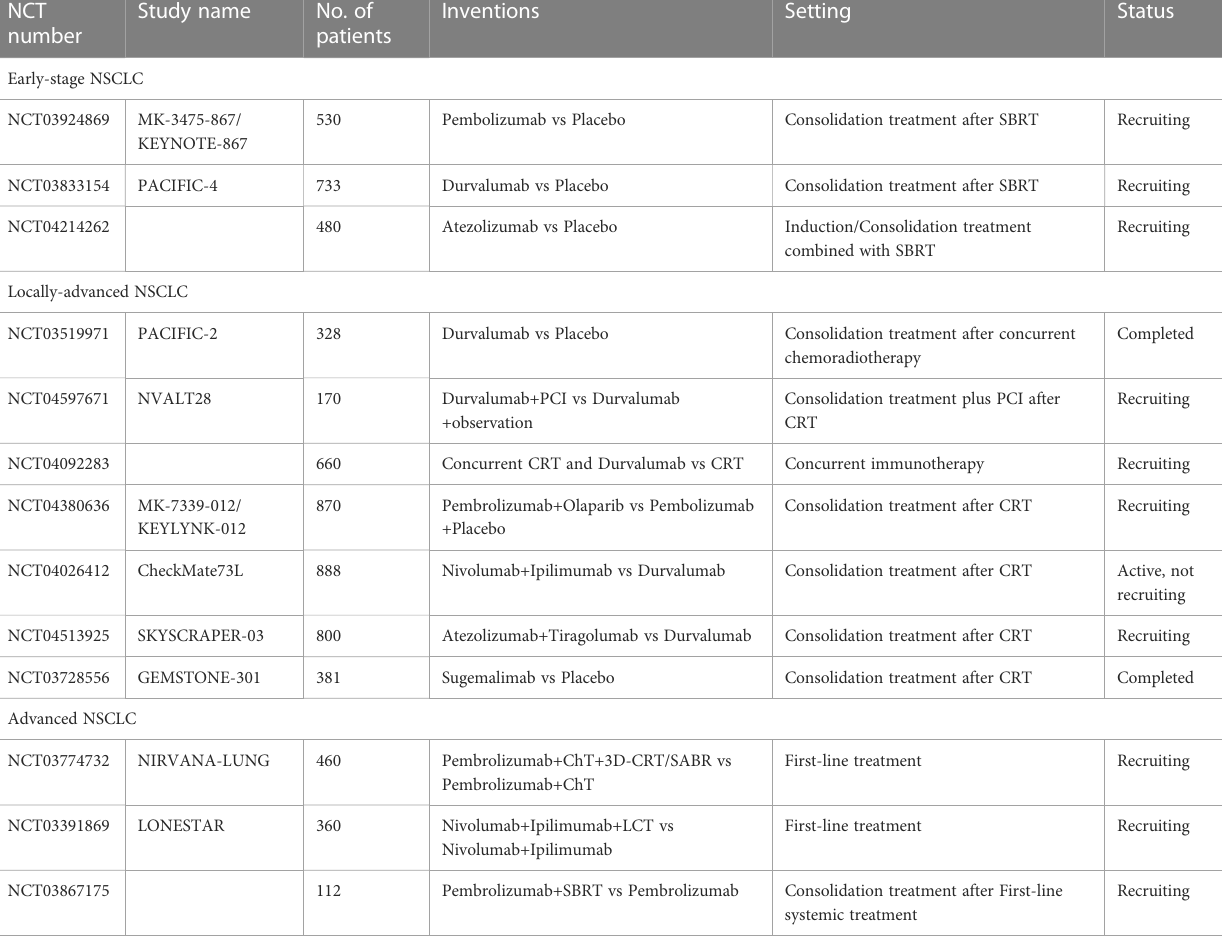
TABLE 1 Summary of ongoing or completed phase 3 trials of immunotherapy combined with RT for